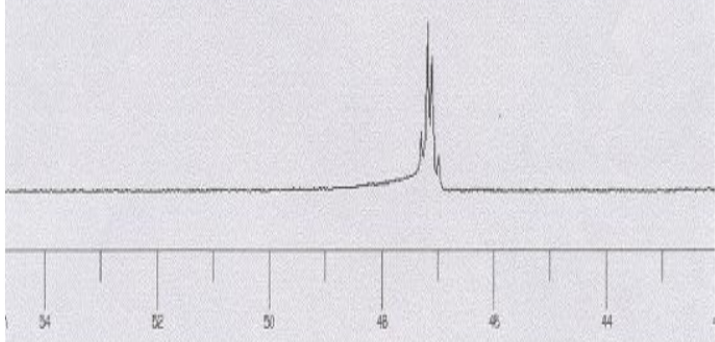
Figure 4. 31 P{ 1 H} spectrum of [ClMo(CO)